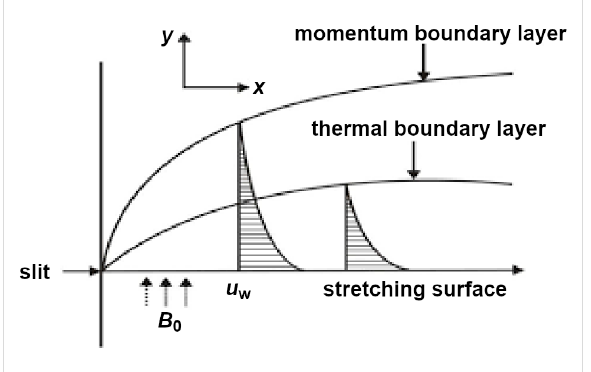
Figure 1 describes the stretching surface of a sheet taken